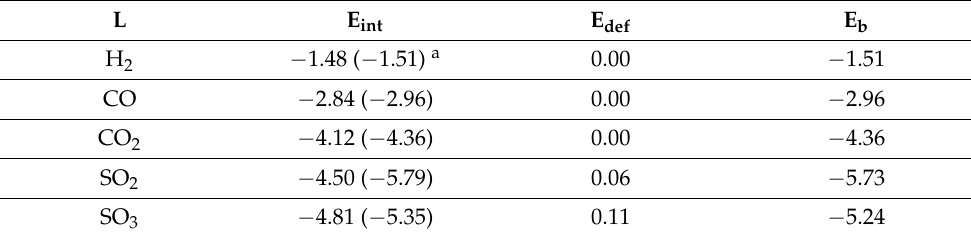
Table 2. Interaction, binding, and deformation energies (kcal/mol) of C 18 ··· L inclusion complexes calculated at the ω B97XD/Def2TZVPP level of theory.